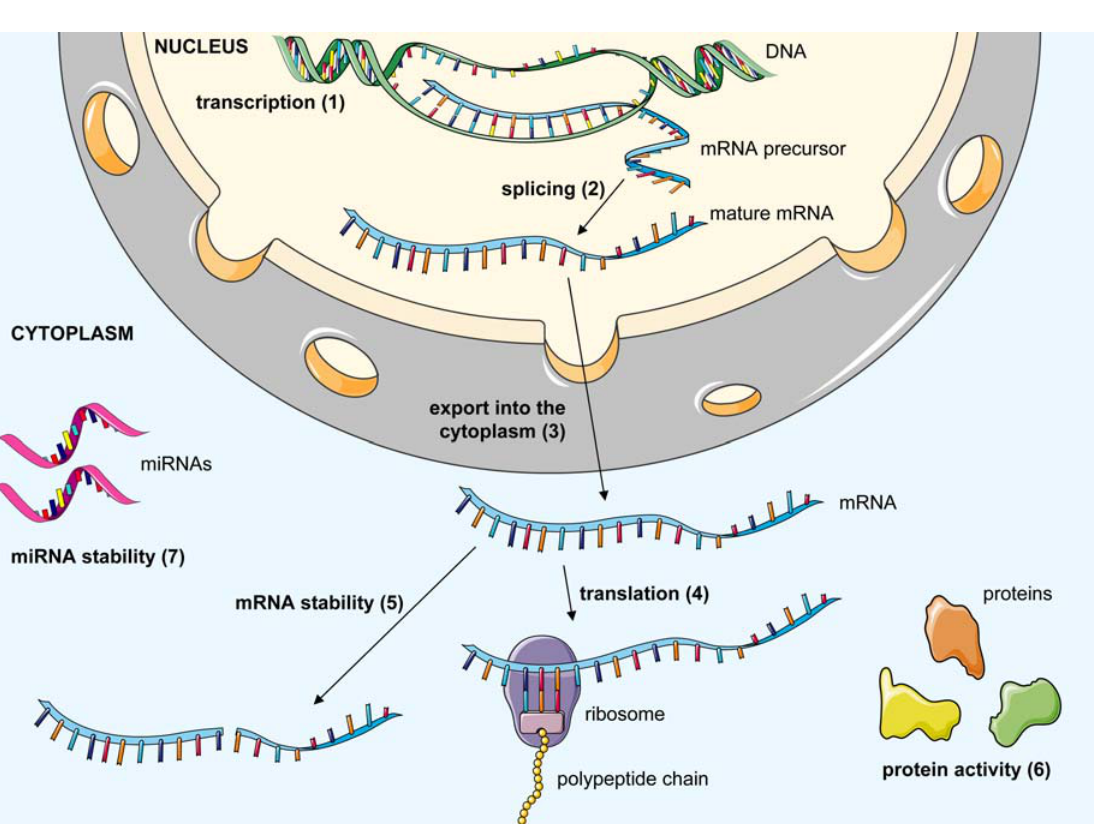
Figure 1. General overview of viral and cellular processes targeted by antiviral oligomeric nucleic acids. Transcription of viral genes (1) may be inhibited by decoys and aptamers which recognize viral regulatory elements or viral transcription factors. AsONs can be designed to bind exon-intron junctions blocking splicing (2) and maturation of mRNA precursors. The export of the viral mRNA into the cytoplasm (3) can be inhibited by asONs which bind the viral RNA or by decoys which bind to viral proteins involved in nuclear export of viral transcripts. Once the mRNA is in the cytoplasm, its translation (4) may be blocked by aptamers or asONs recognizing regions within or in the vicinity of the translation start site. AsONs, siRNAs, siDNAs and ribozymes can affect stability of the mRNA (5) by direct cleavage or by inducing its degradation via cellular enzymes. The activity of viral proteins (6) can be blocked by decoys, short oligonucleotides and aptamers which bind with high affinity to their targets. They can induce conformational changes of the protein or compete for binding with its natural substrate/ligand. In the specific case of HCV, a cellular miRNA (miR-122) has been shown to facilitate viral replication. Hence, miRNA inhibitors can be used to block and affect stability of specific miRNAs (7). This figure was produced using Servier Medical